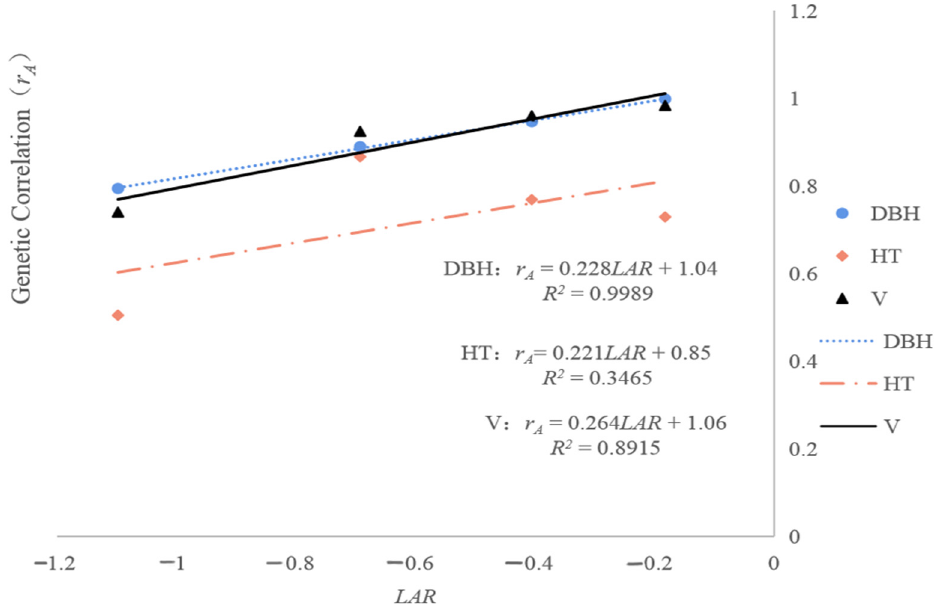
Figure 3. Relationship of LAR ( log e (age young /age old )) to age–age genetic correlations.